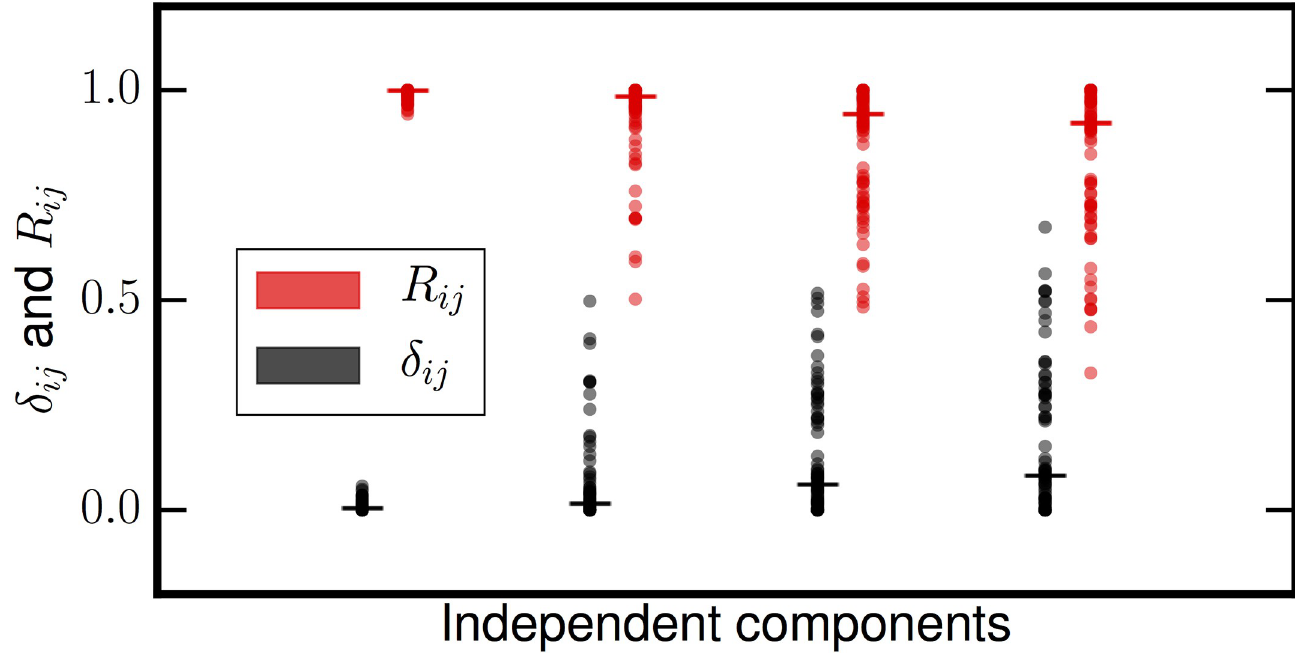
Fig 6. Reproducibility plot for the Iris data. The format and color scheme for this figure is identicalto that used in Figs 4 and 5. Based on this informationand related discussion in the text, it appearsthat there is one (and likely only one) sparse source present in the iris data.